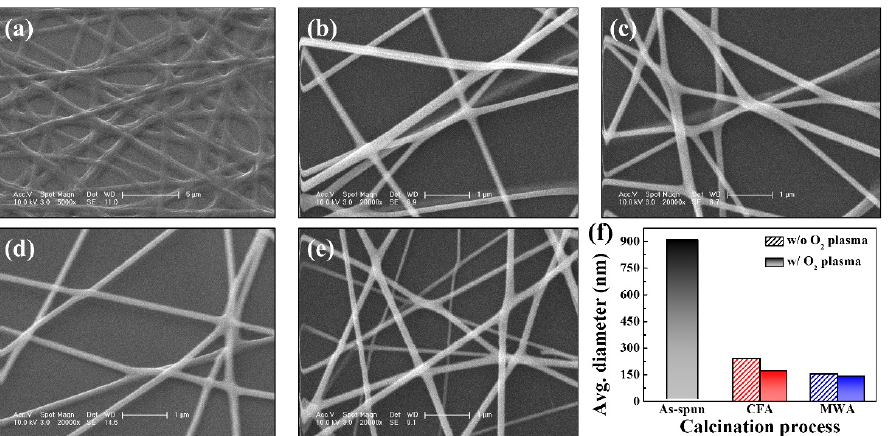
Figure 3. SEM images of electrospun IGZO NFs: ( a ) as-spun (×5000); CFA-calcined NFs ( b ) before and ( c ) after oxygen plasma treatment (×20,000); MWA-calcined NFs ( d ) before and ( e ) after oxygen plasma treatment (×20,000). ( f ) Average diameters of 20 fibers randomly selected from SEM images.